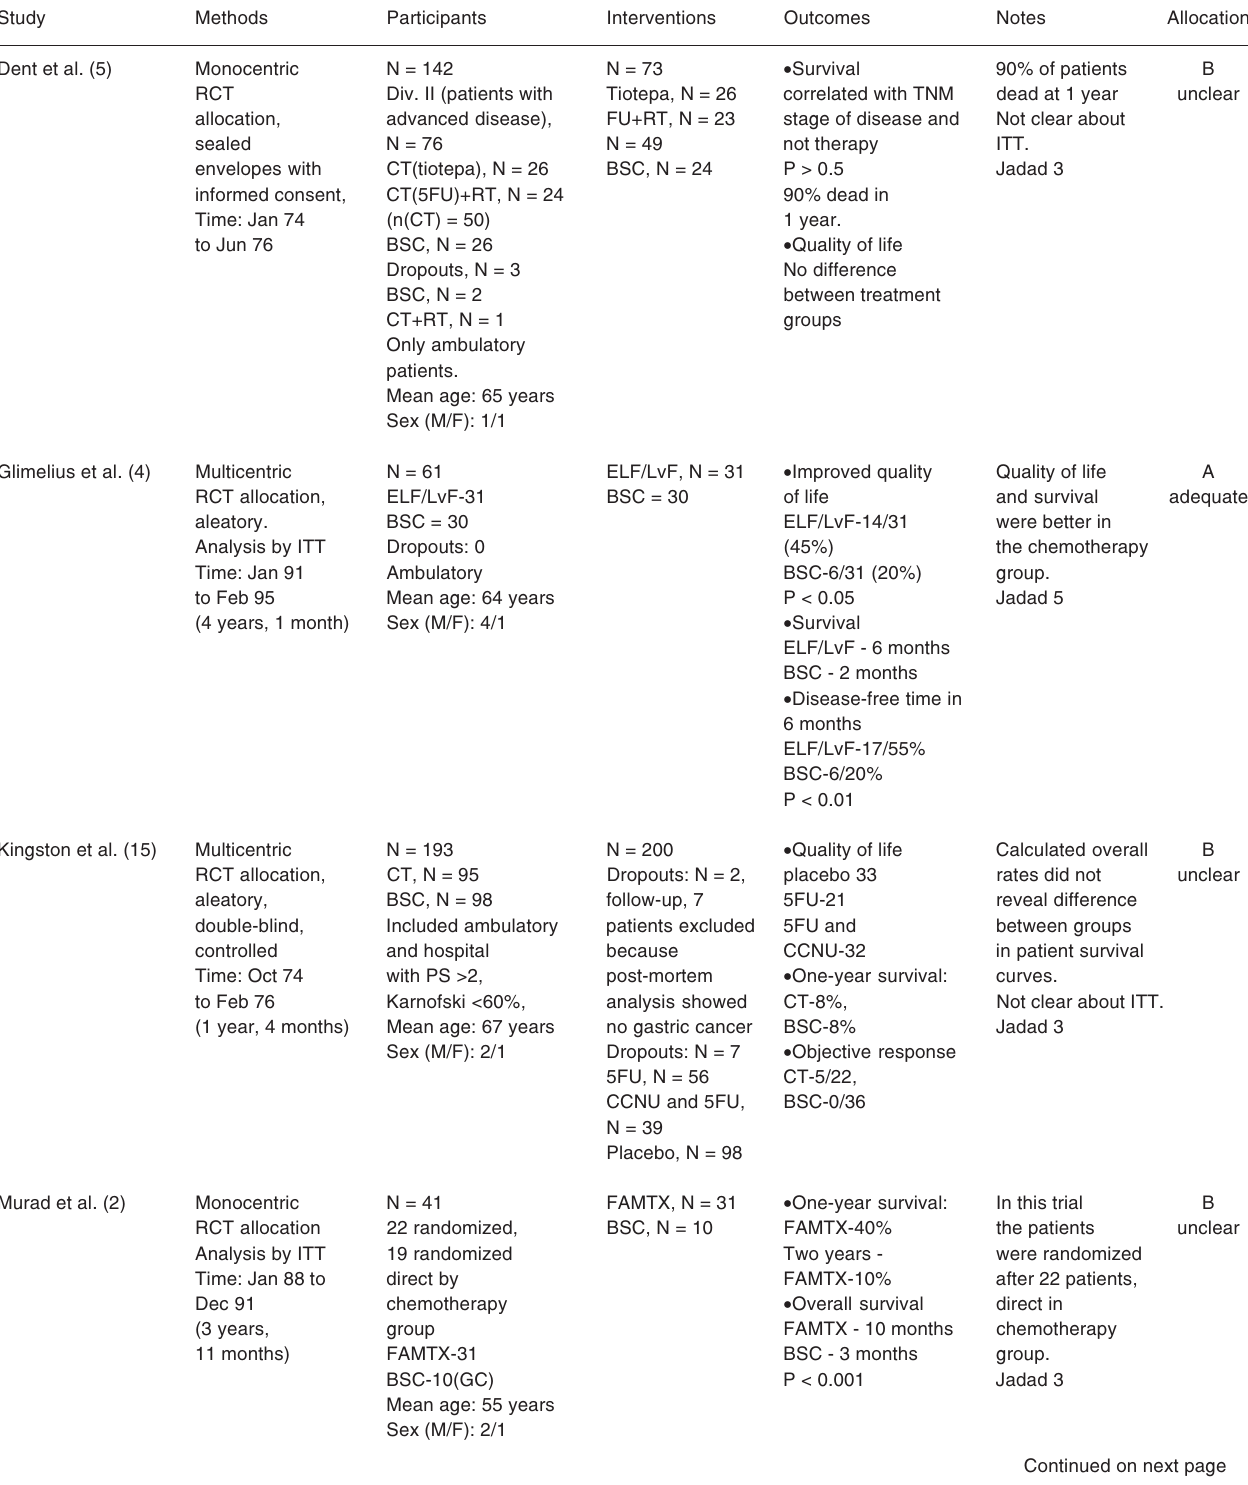
Table 5. Characteristics of the studies